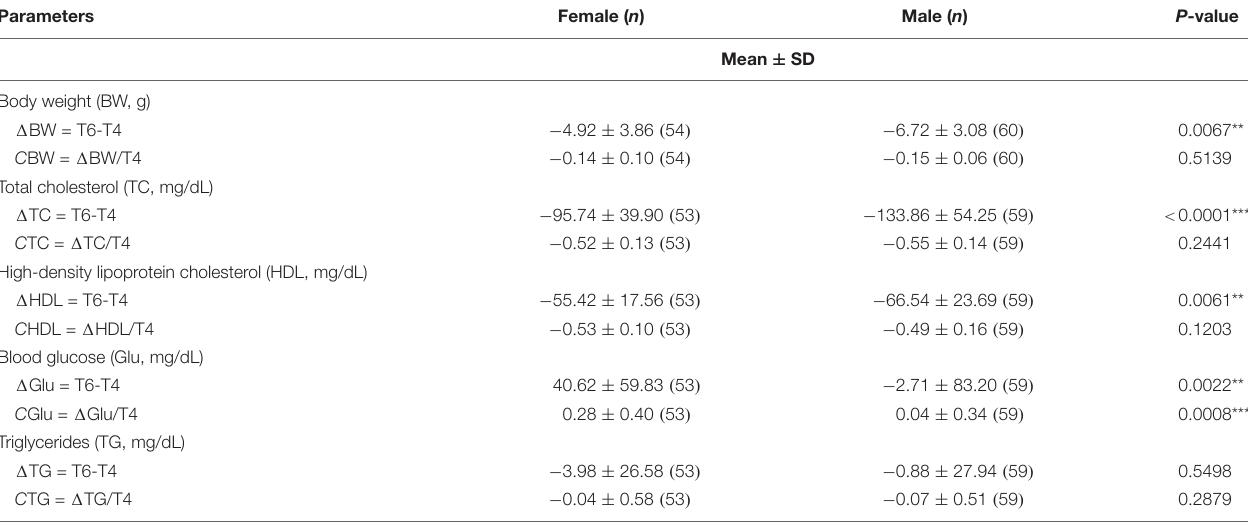
TABLE 4 | Main effect of gender on absolute and relative changes in body weight and blood biochemistry among treated mice. Parameters Female ( n